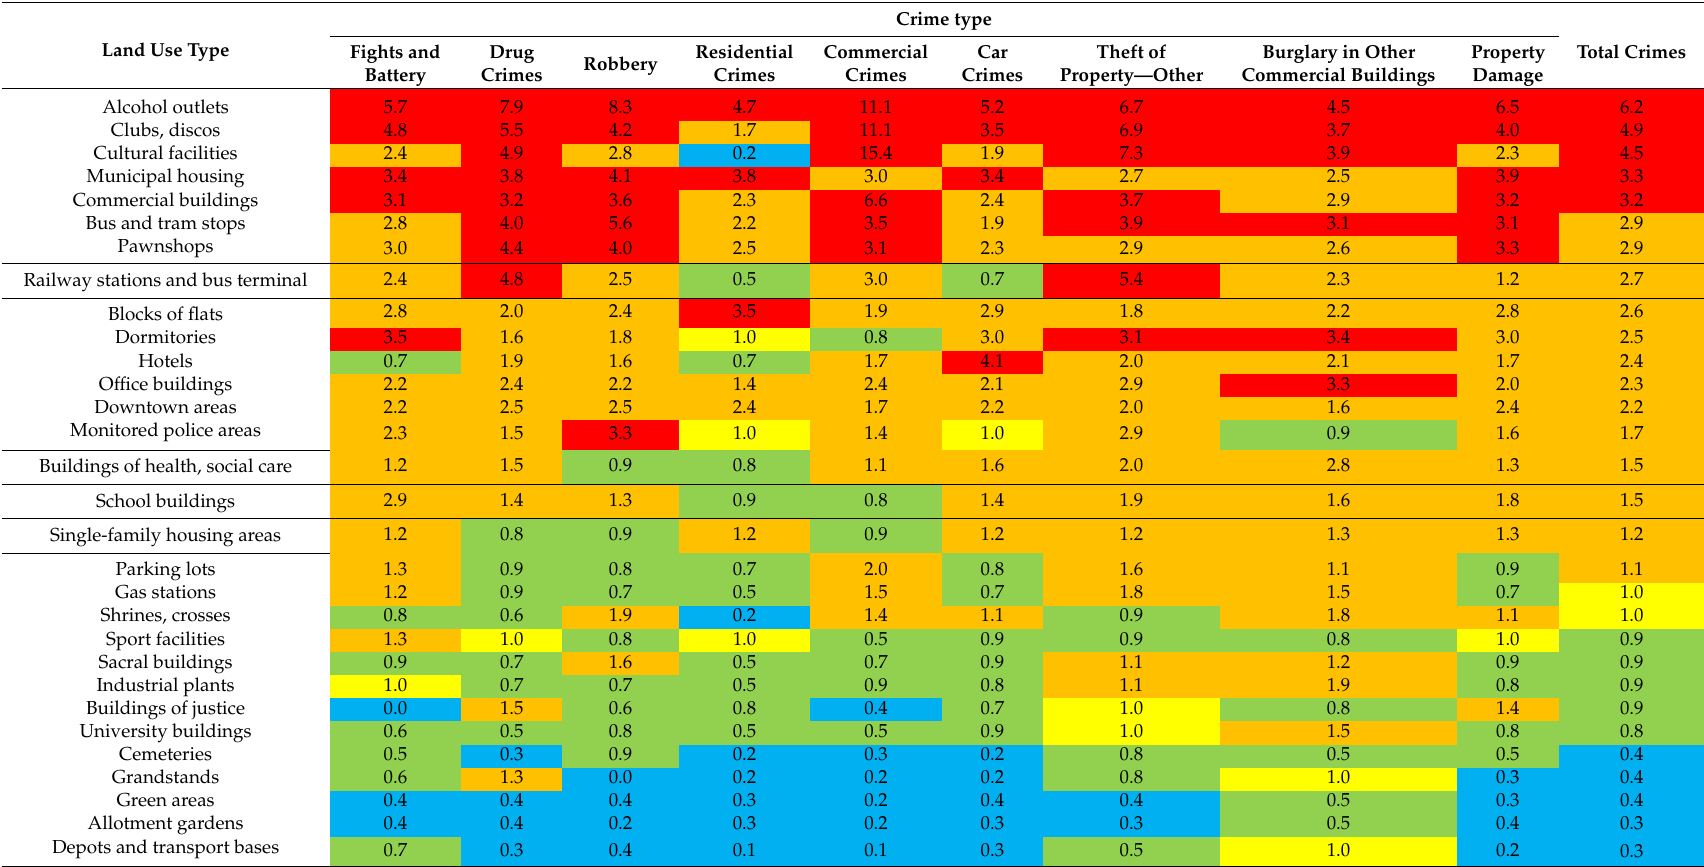
Table 6. LQCs of total crimes and crime types in the distance zone 0–50 m around land use